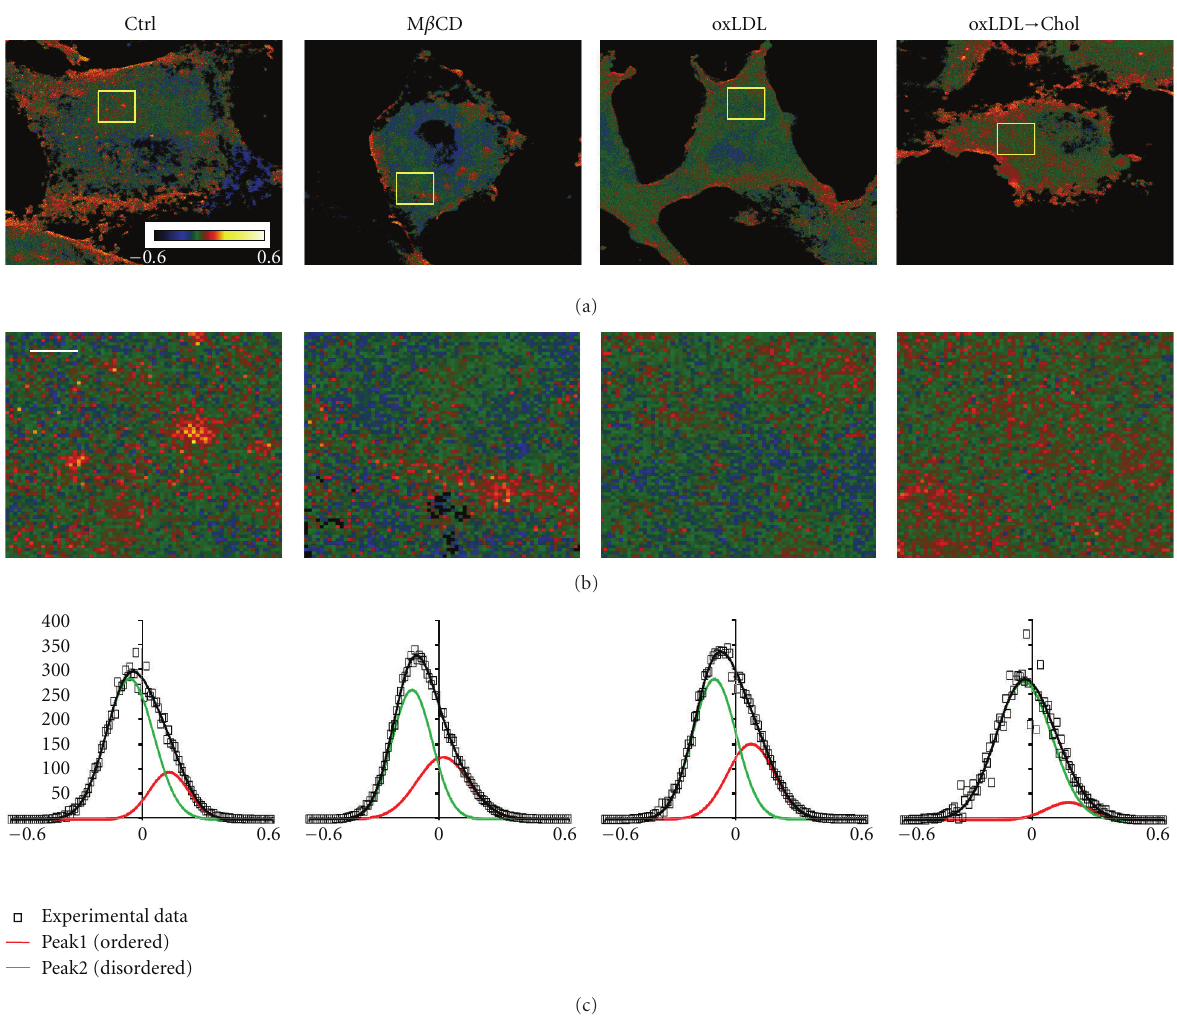
Figure 5: Impact of oxidized low-density lipoprotein (oxLDL) on lipid packing of membrane domains in bovine aortic endothelial cells. (a) Typical general polarization (GP) images of control cells (Ctrl), M β CD-treated cells, oxLDL-treated cells (oxLDL), or cells exposed to oxLDL and M β CD-cholesterol sequentially (oxLDLChol). Scale bar is 5.6 μ m. (b) zoom-in representative regions of the GP images shown in (a) (the zoomed regions are 5 . 6 μ m × 5 . 6 μ m). Scale bar is 1 μ m. (c) GP histograms for the four experimental cell populations (dots) fitted by a two-Gaussian distribution with the curve representing ordered domains (red) and the curve representing fluid domains (green). The sum of the Gaussians is shown in black. Adapted from